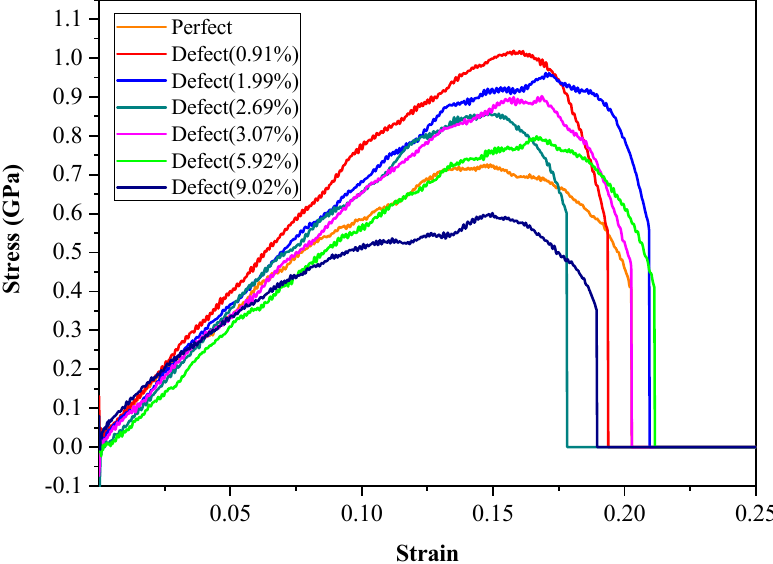
Figure 2. The strain–stress curves in the Z-axis of di ff erent deletion percentage of hydrate systems during stretching.